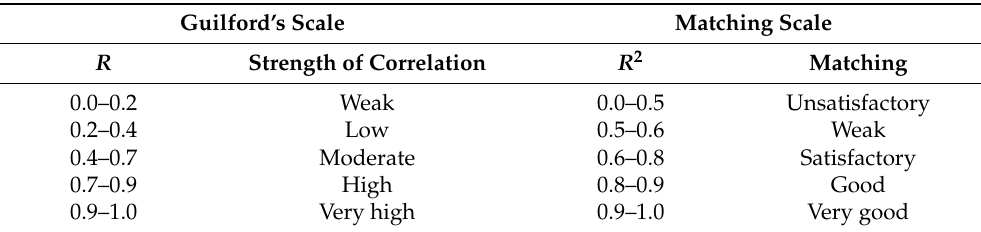
Table 2. Guilford Scale and Match